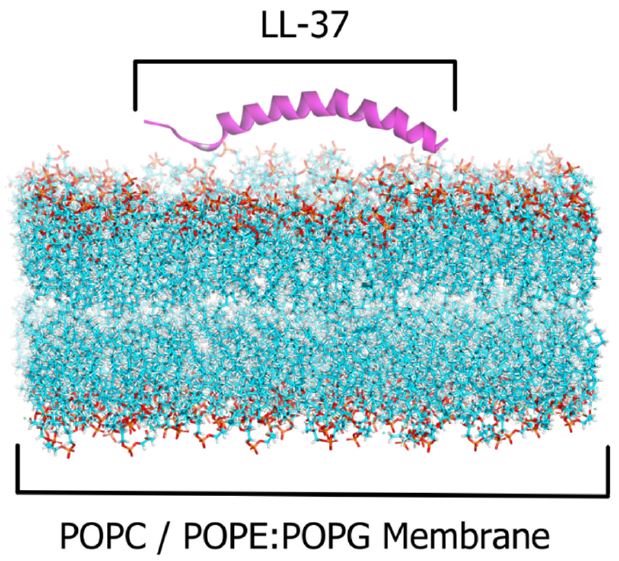
Figure 7. The LL-37–POPC and POPE:POPG membrane simulation system as an AMP–bacterial cell membrane interaction model. The peptide is displayed with purple cartoon models, and the membrane is displayed with solvent models.